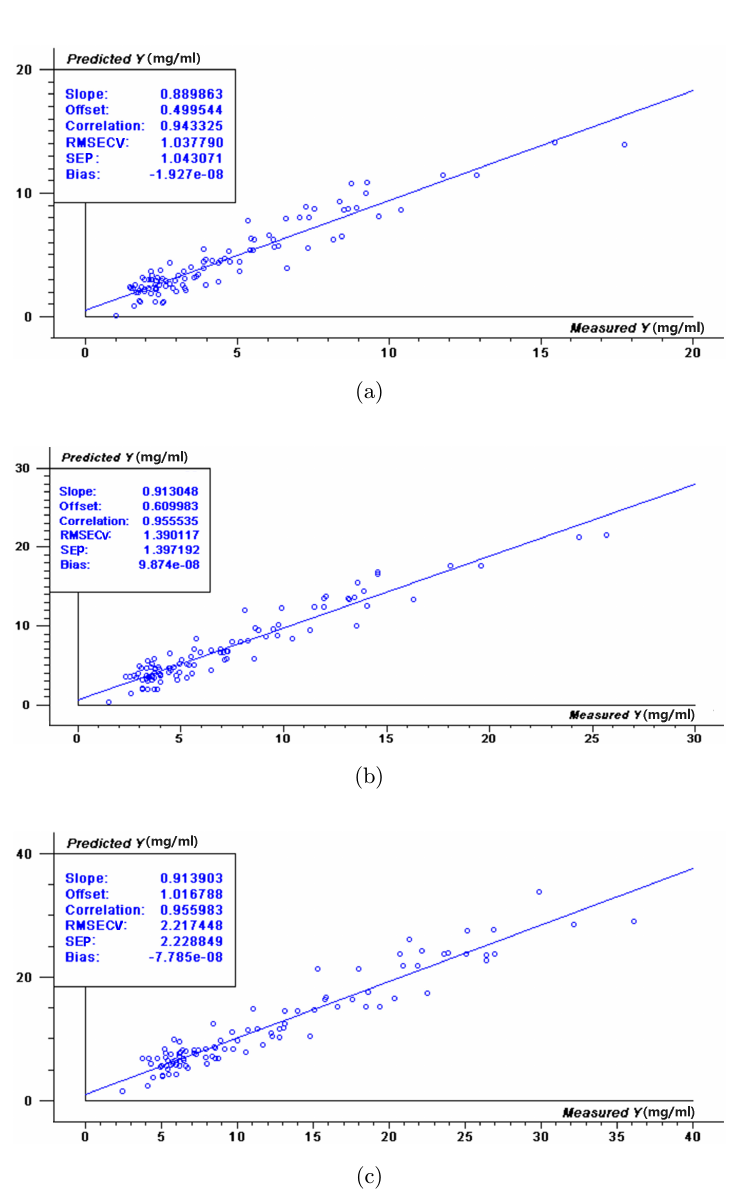
Fig. 3. PLS NIR-model validation plots for saccharides of Danshen: (a) glucose, (b) fructose, and (c)